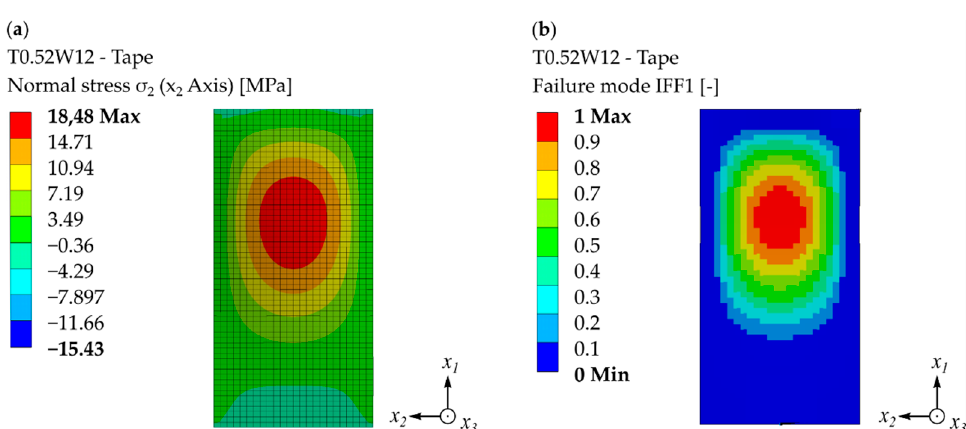
Figure 6. ( a ) Plot of the distribution of σ 2 stresses of the tape configuration T0.56W12 and ( b ) the inter-fiber tensile failure mode (IFF1) for all elements of the tape at the point of failure. The tape configurations that have a lower width to height ratio usually fail in the form of fiber compression failure instead of inter-fiber tensile failure due to the generation of lower σ 2 normal stresses across the width. To display this effect, the σ 2 -normal stresses for the three configurations T0.26W12, T0.26W9, and T0.26W6 at the point of failure were compared (Figure 7).